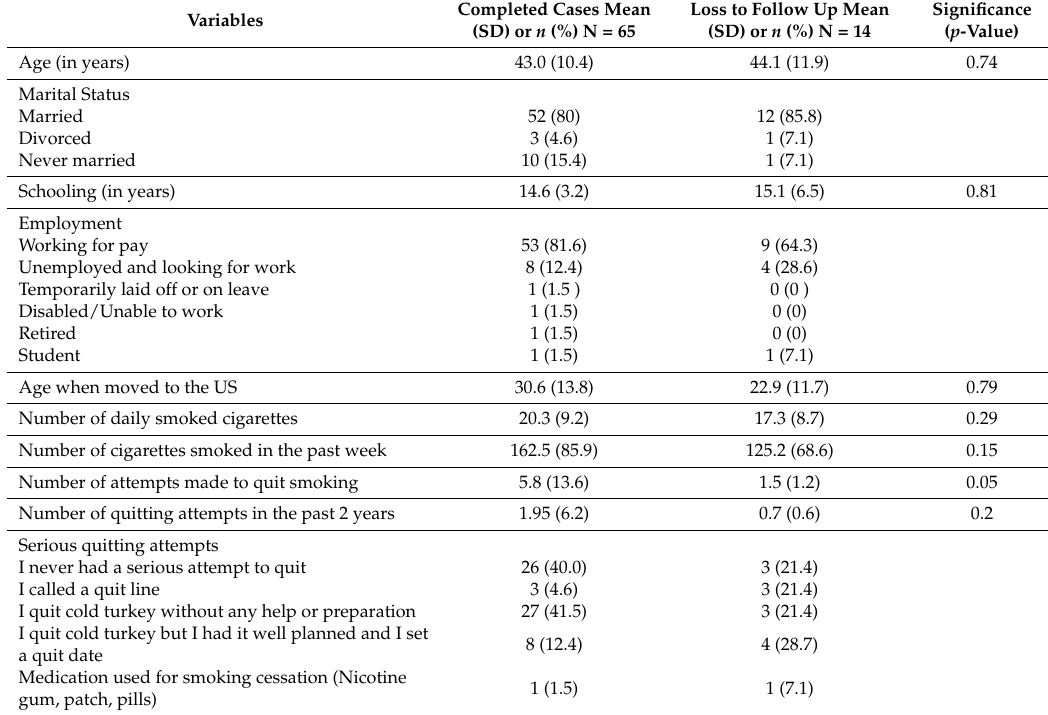
Table 3. Characteristics of participants lost to follow-up in comparison to the completed cases (N =